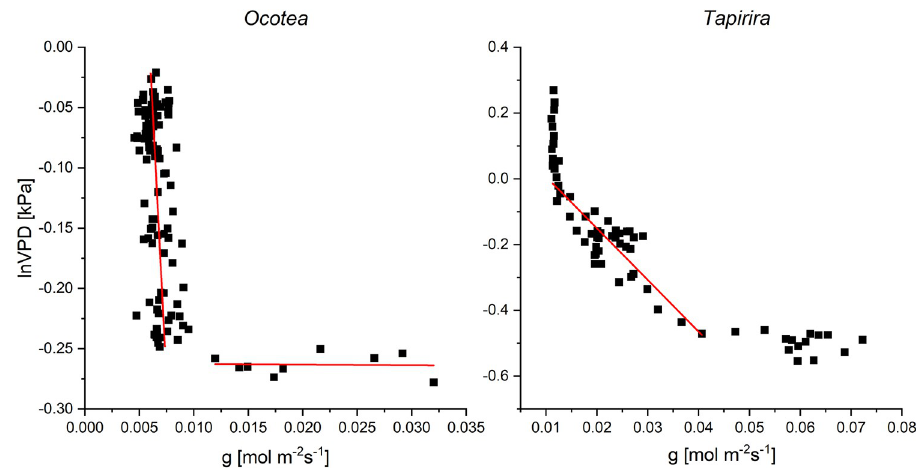
Fig 9. Nighttime (19:00 to 6:00) response of leaf conductance (g leaf ) to lnVPD (following Oren et al. 1999) of Tapirira and Ocotea ,